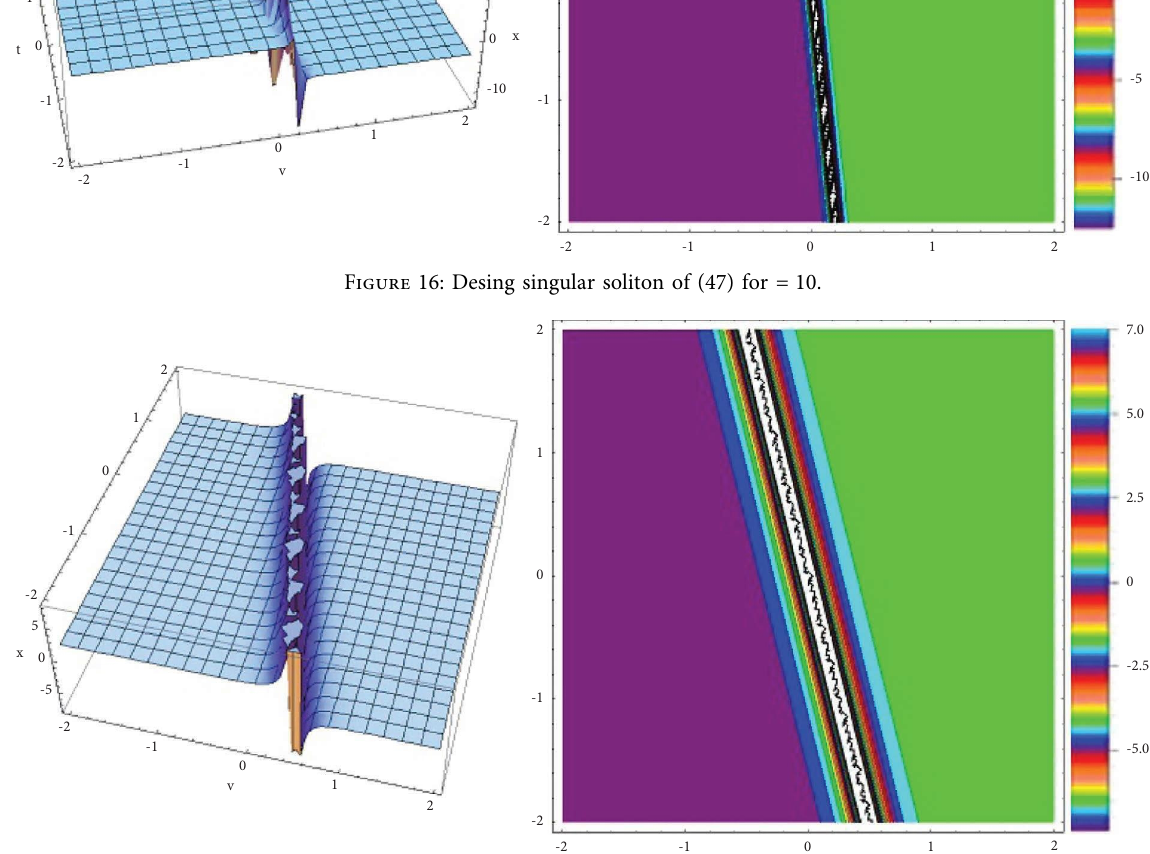
Figure 17: Desing of singular soliton of (47) for � 4.